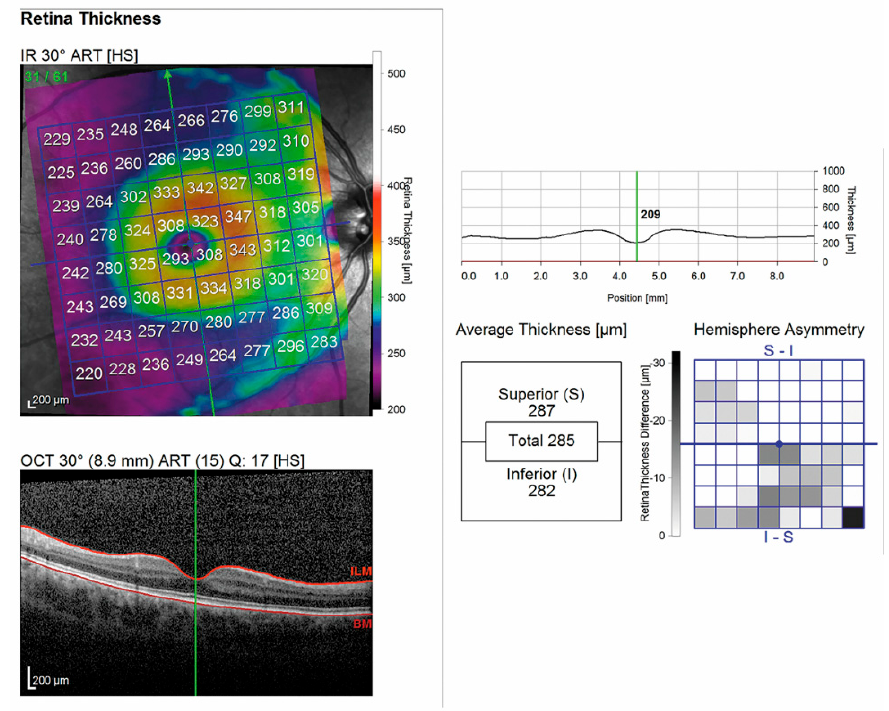
Figure 1. OCT scan of the posterior pole in a patient affected by MS.